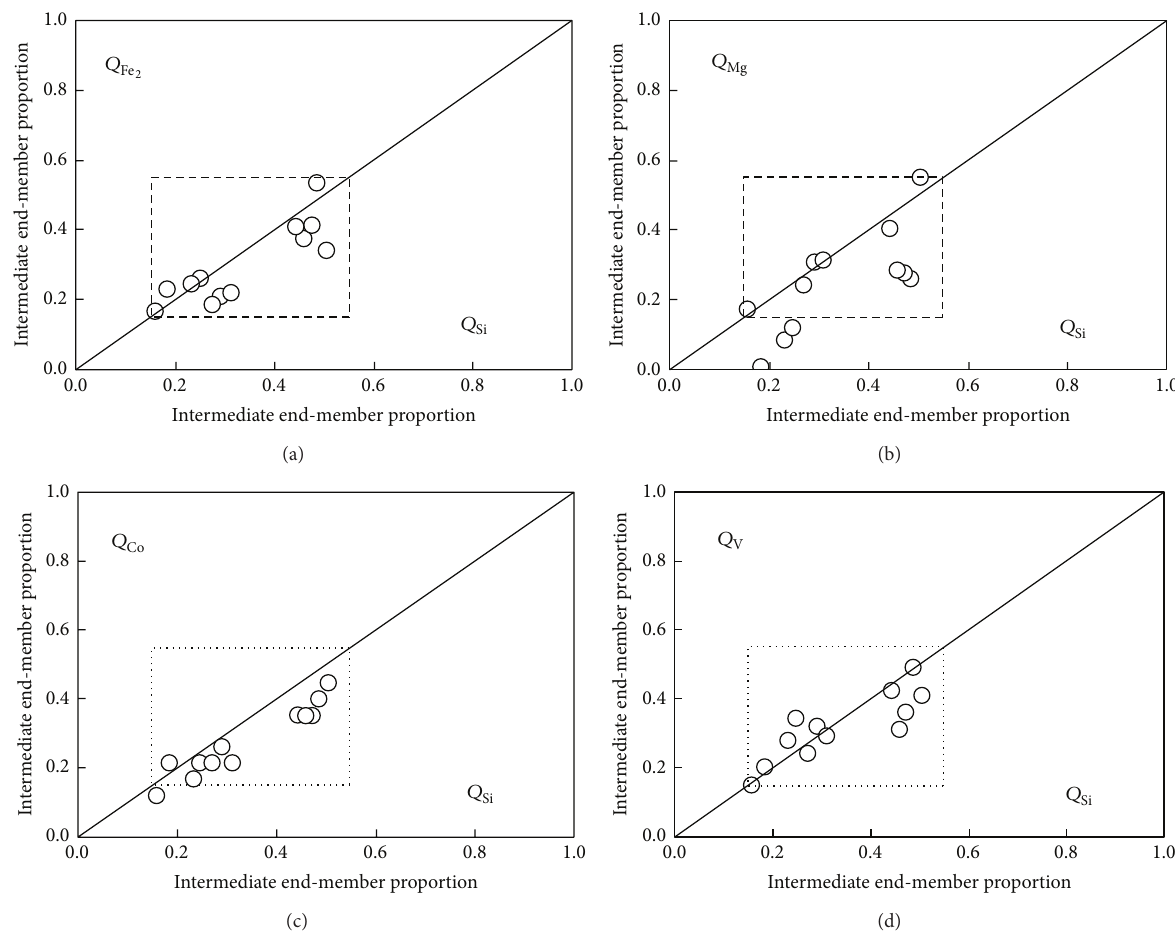
Figure 13: Mean proportions of mafic end-members in the comingled lavas from the Sierra de las Cruces, calculated using the mass-balance equation 𝑄 𝑖 𝐴 = |𝐶 𝑖 𝑀 − 𝐶 𝑖 𝐵 |/|𝐶 𝑖 𝐴 − 𝐶 𝑖 𝐵 | [31] for [ SiO 2 ] against those obtained using the other constituents. The diagonal line indicates perfect agreement between